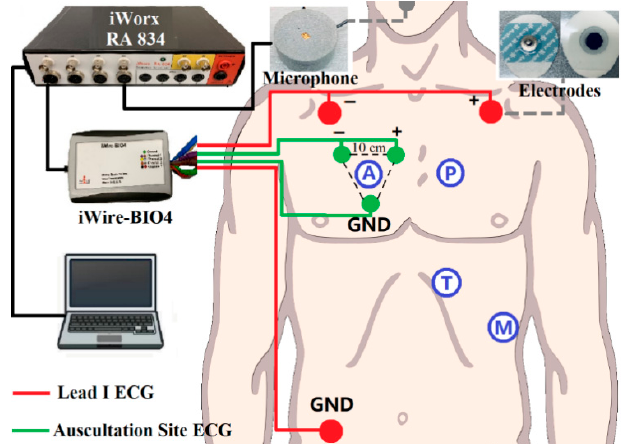
Figure 2. Block diagram of the recording setup: Red dots are Lead I Electrocardiogram (ECG) as a reference, green dots are auscultation site ECG. The grey dot is the microphone for respiration recording. iWire BIO4 is for ECG recording. All the data is transferred to the computer for processing through iWorx RA 834.